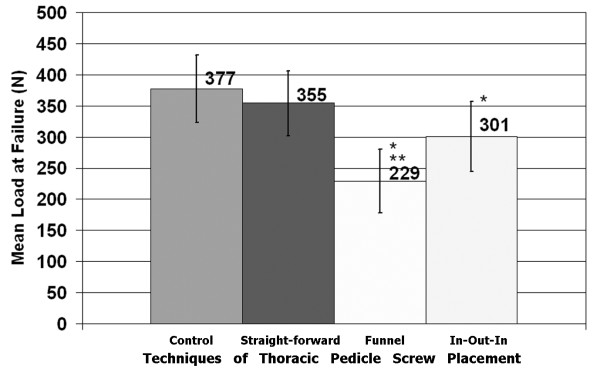
Mean load-to-failure for each of the four study groups. Error bars represent 95% confidence intervals of the estimated means. *Significantly different from intact control, P < 0.05. **Significantly different from straight-forward and significantly different from in-out-in, P < 0.05.